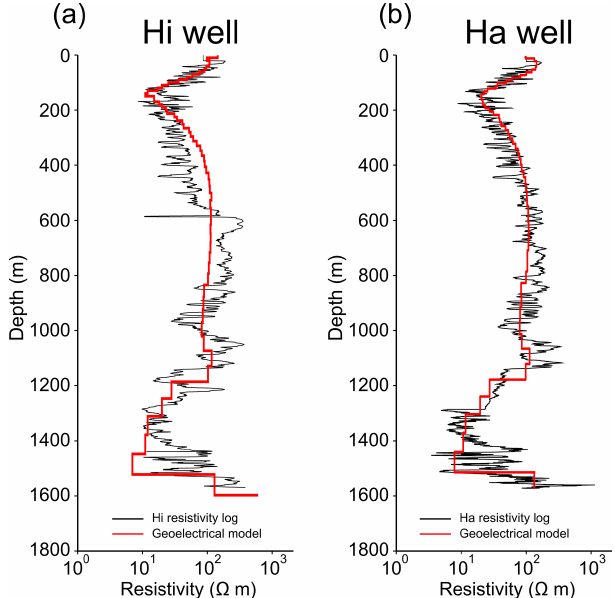
Figure 4. Comparison between the resistivity log data (in black) and resistivity model provided by the column of the 3-D geoelectrical model located at the well position (in red) for the Hi (a) and Ha (b)